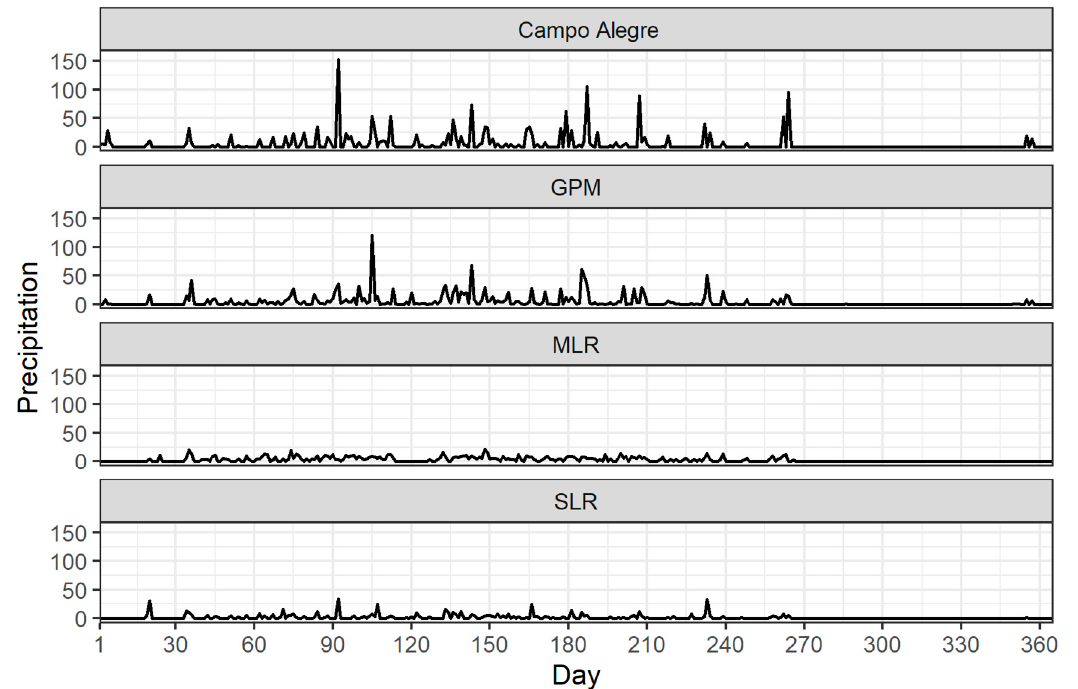
Figure 5. Direct comparisons between daily precipitation estimates and observed data for the period from 1 September 2016 to 31 August 2016 at the Campo Alegre station. OBS, observed data; MLR, multiple linear regression method; SLR, simple linear regression; GPM, Global Precipitation Measurement method.